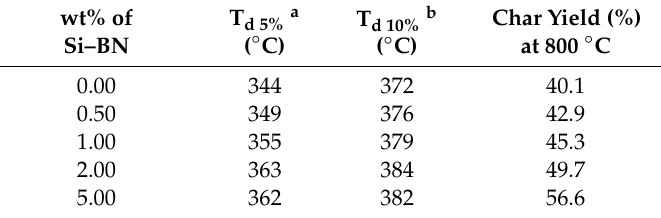
Table 2. Thermal stabilities of K–LCE / BN composites.